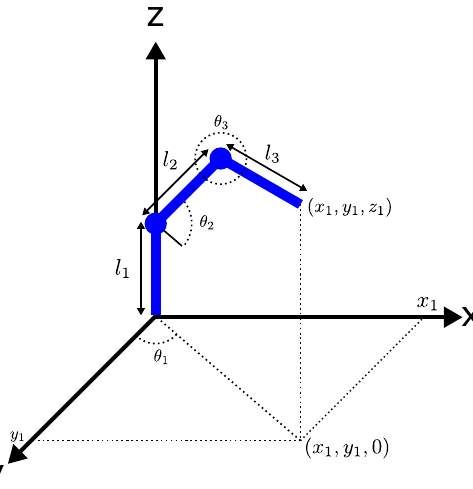
Figure 3. Geometrical model of a 3-DoF robot.